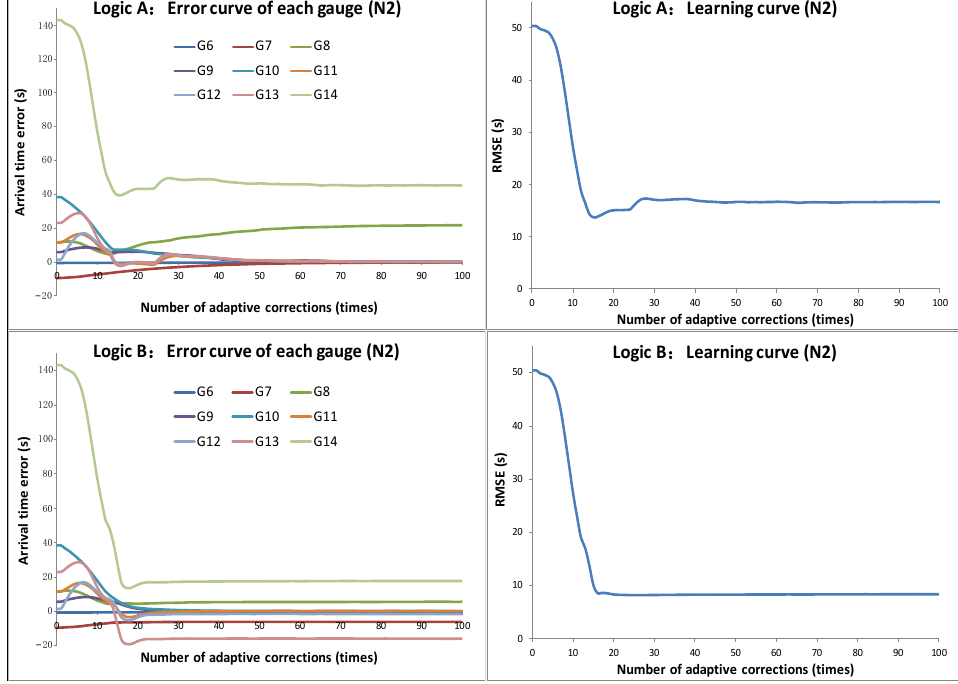
Figure 10. Error curve and learning curve of each gauge in logic A and logic B ( N 2